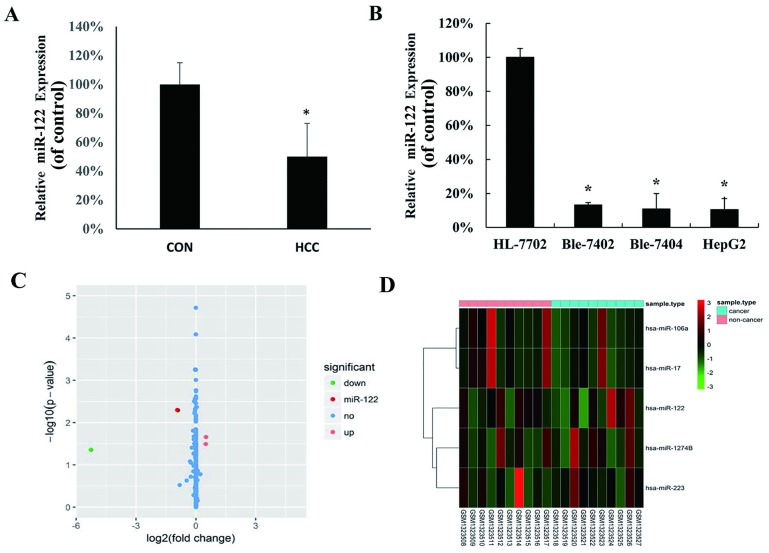
MiR-122 expression in hepatocellular carcinoma (HCC) cell lines and tissues.(A) MiR-122 expression was examined by quantitative real-time polymerase chain reaction (qRT-PCR) in human HCC tissues and adjacent normal tissues (control group); (B) qRT-PCR analysis of miR-122 expression in normal liver cells (HL-7702, as control group) and three HCC cell lines (HepG2, Bel-7402 and Bel-7404). MiR-122 expression in each sample was normalized to that of U6, the internal control (*P < 0.05 vs. control group). (C) Volcano plot of the DEGs. DEGs were selected with P < 0.05 and fold change > 2. (D) DEGs can be effectively divided into hepatocellular carcinoma tissues and adjacent non-cancerous tissues groups. Up-regulated and down-regulated genes were represented by red and green, respectively.